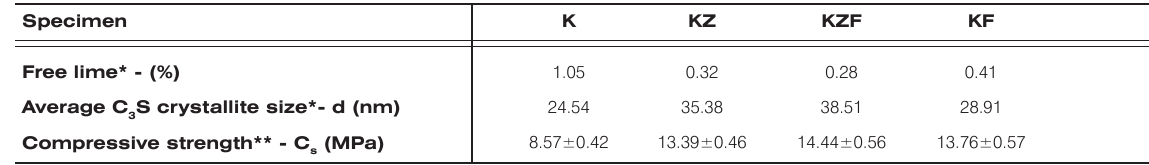
Table 3. Characteristics and properties of synthesised biocements.